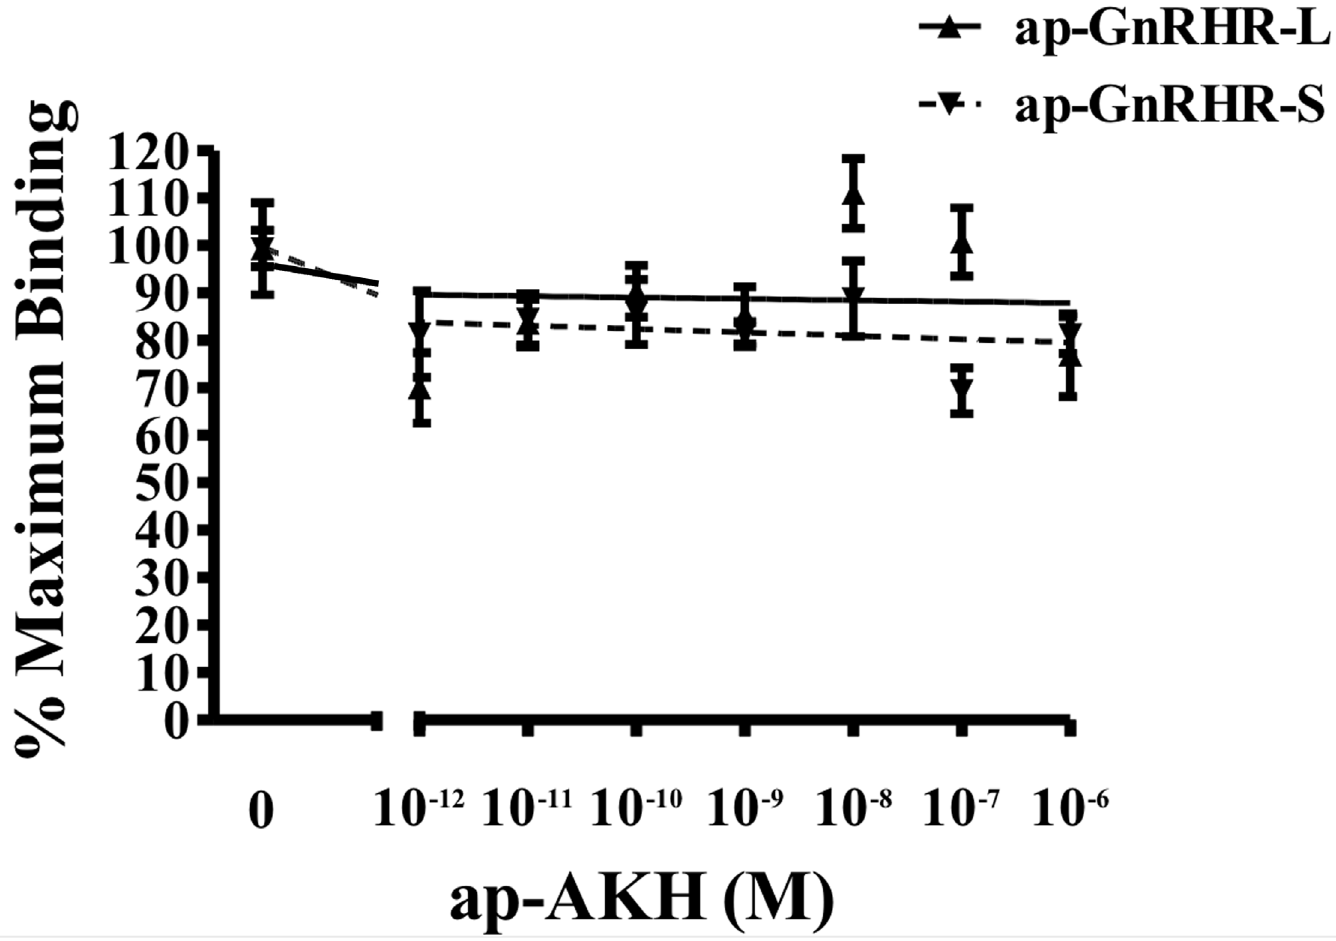
Fig 6. Analysis of [ 125- I]-ap-GnRH binding to S2 cells transfected with ap-GnRHR-L or ap-GnRHR-S. Binding to the radioligand was not displaced by increasing concentrations of unlabeled ap-AKH in S2 cells transfected with either ap-GnRHR-L or ap-GnRHR-S. Binding data are expressed as the percentage of [ 125 I]-ap-GnRH binding to the respective receptor in the absence of unlabeled hormone. Each data point represents N = 3 assays run in triplicates.